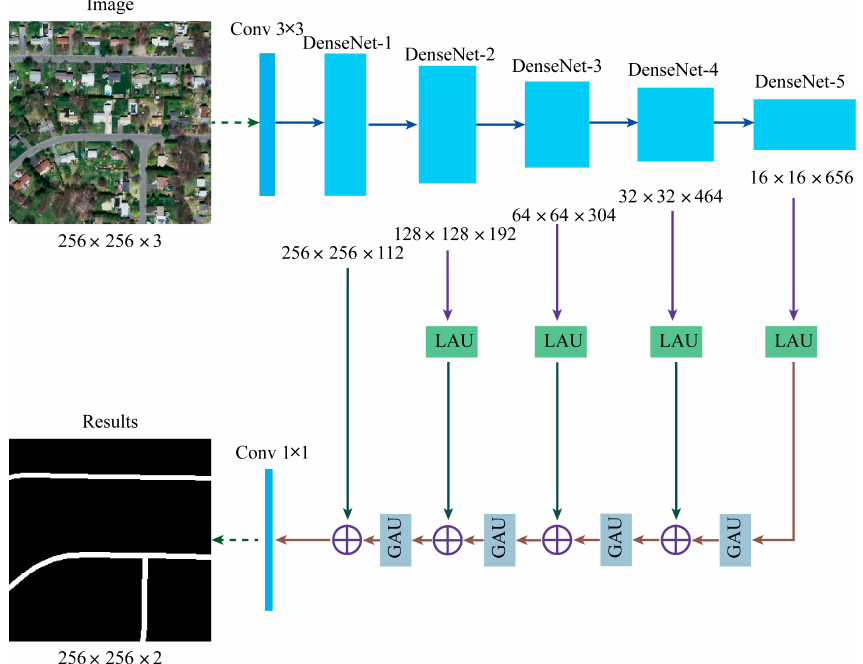
Figure 1. The architecture of the GL-Dense-U-Net used in this work.